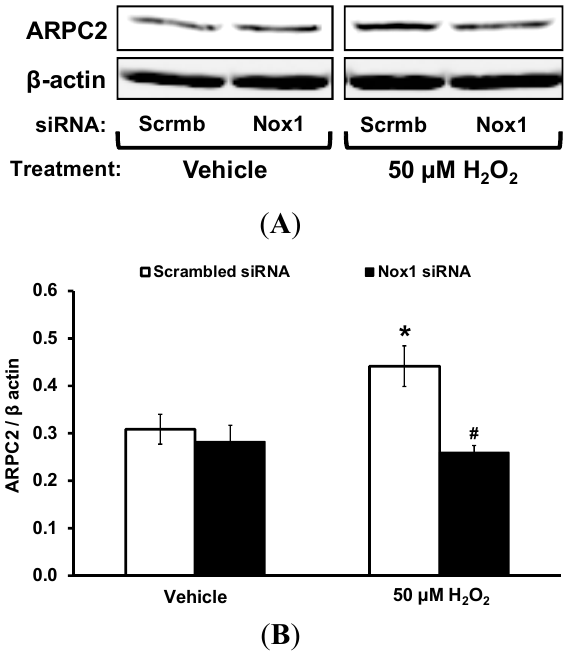
O for 3 h. VSMC 2 2 O 2 2